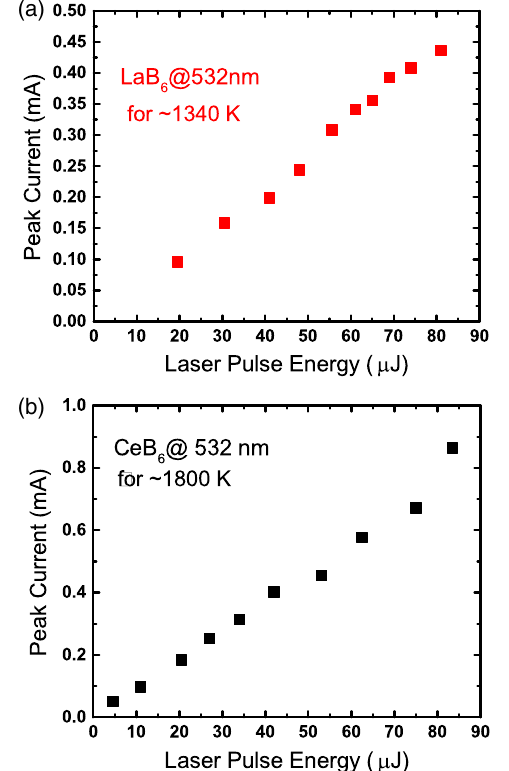
FIG. 11. Dependence of the peak photoemission current on laser pulse energy at 532 nm. (a) LaB 6 for the cathode temper- ature of around 1340 K. (b) CeB 6 for the cathode temperature of around 1800 K. For (a) and (b) the laser illuminated area was 1.72 mm in diameter.